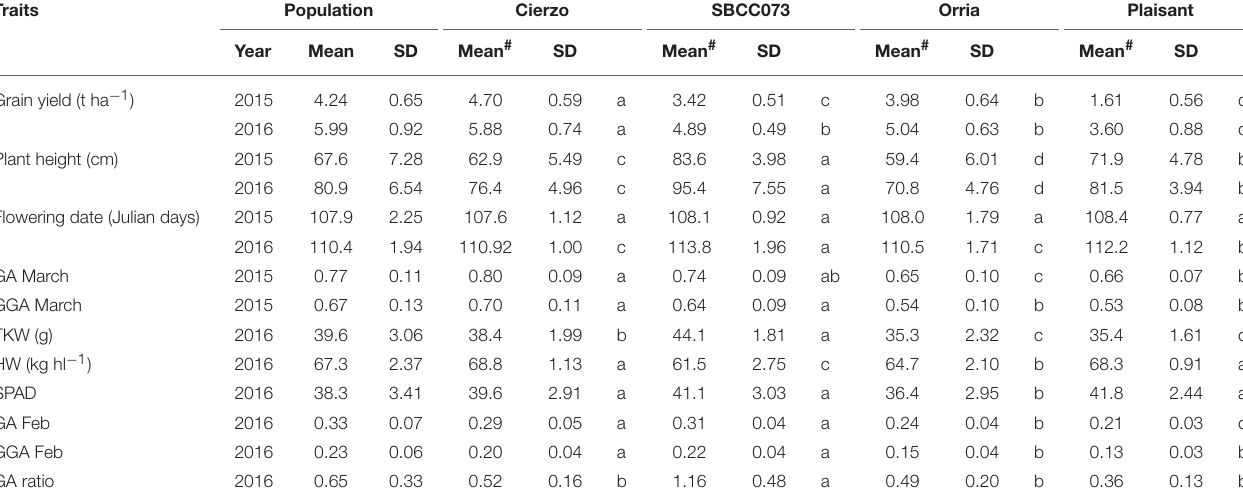
TABLE 2 | Traits averages for the SBCC073 × Cierzo population, parents and checks.